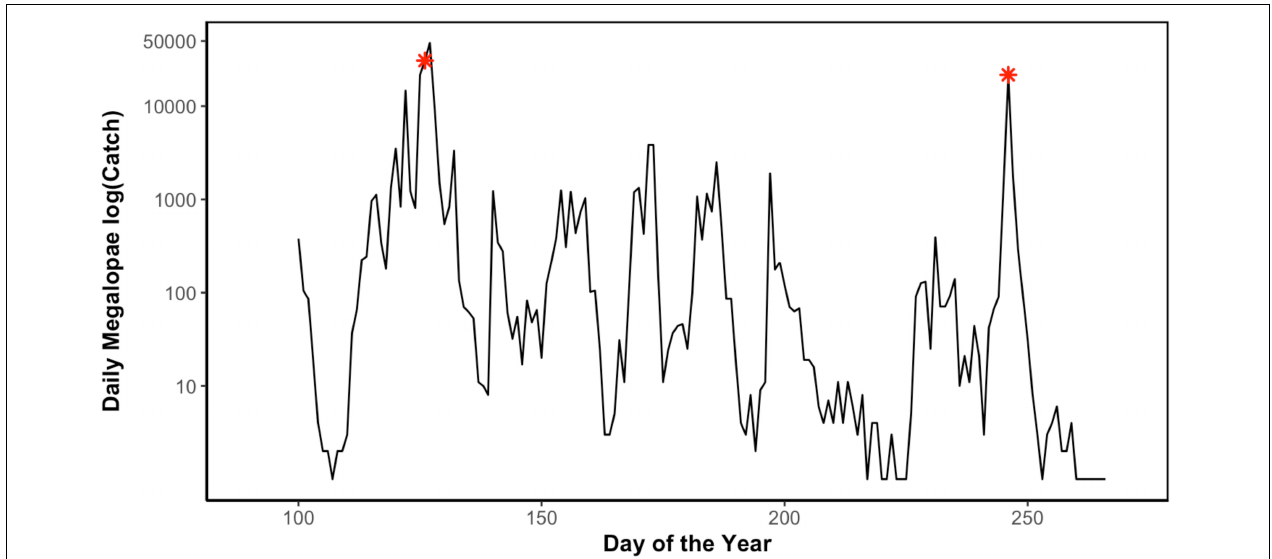
FIGURE 3 | Daily Dungeness crab ( C. magister ) megalopae catch in Coos Bay, Oregon light trap during the 2014 recruitment season (April 10–September 29) (Julian day of year). Asterisks ( ∗ ) indicate sampling points when megalopae recruits were collected for genomic analyses (May 7 and September 3) (unpublished data Shanks,